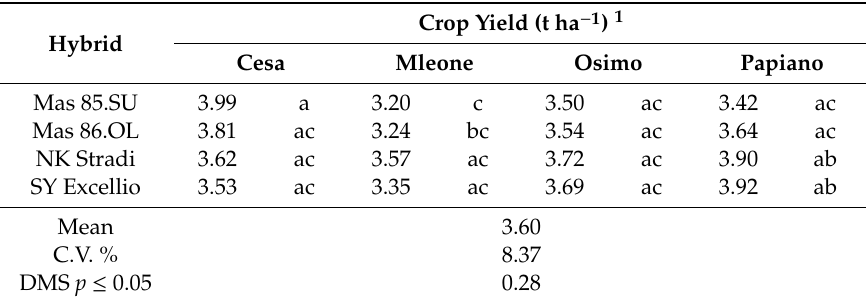
Table 3. Yield of hybrids in di ff erent locations.